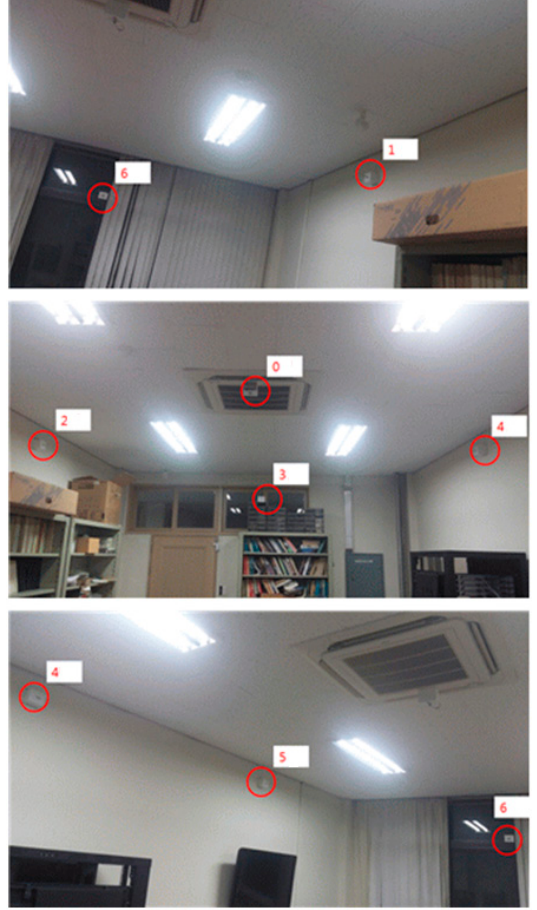
Figure 12. Actual Deployment Status of Location Beacons in the Testing Space. Figure 12. Actual deployment status of location beacons in the testing